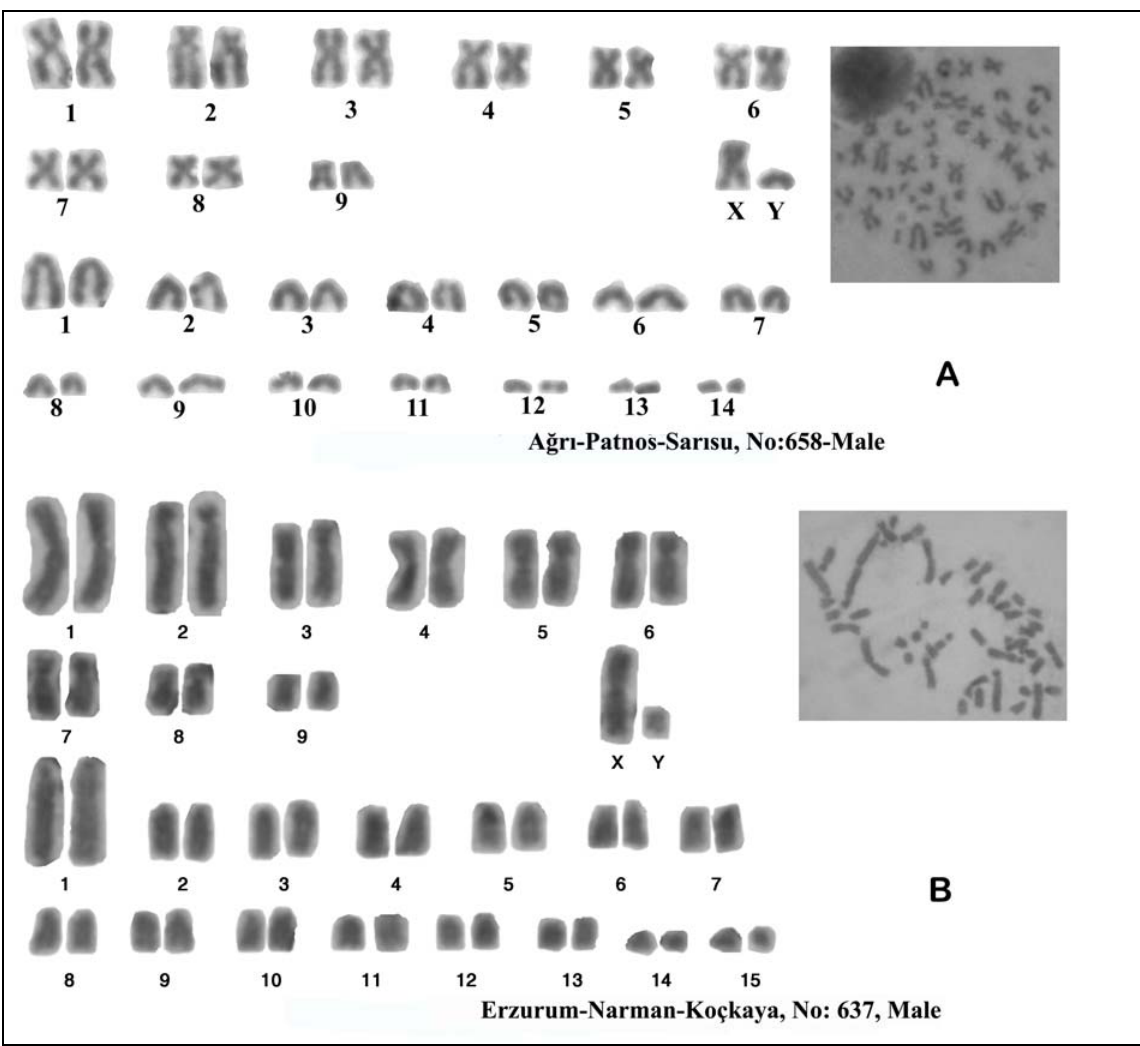
2n = 50 from Kars and Erzurum